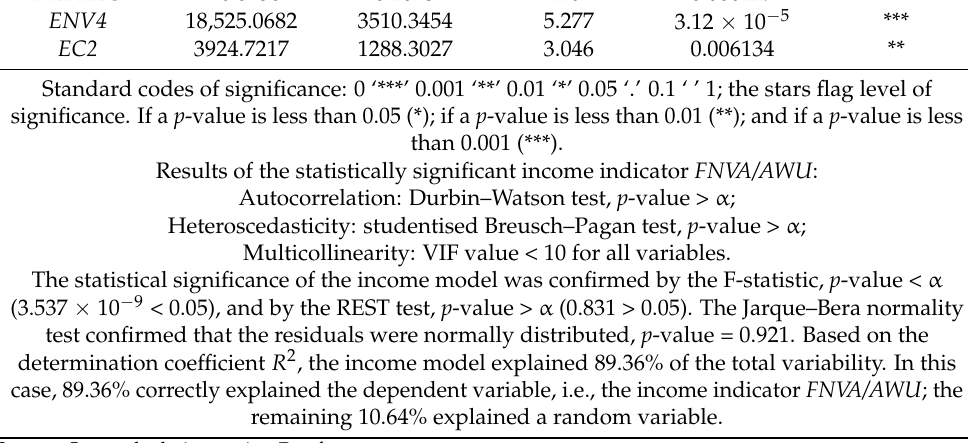
Table 2. Results of regression analysis for the income indicator FNVA/AWU. Estimate